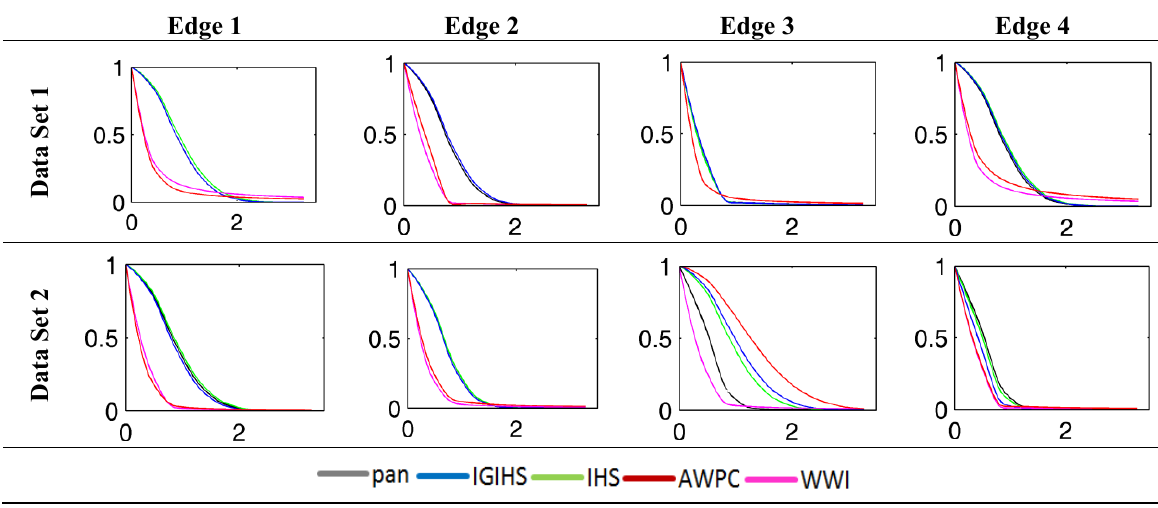
Figure 11. MTF curves, pan-sharpened and pan-image, x-axis shows the frequency and y-axis the MTF value.